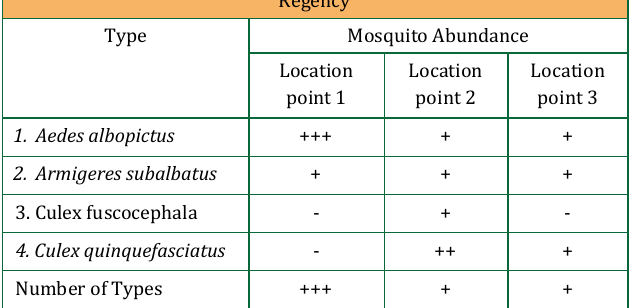
Table 2: Qualitative abundance of mosquito species at several locations in Kahyapu Village, Enggano District, North